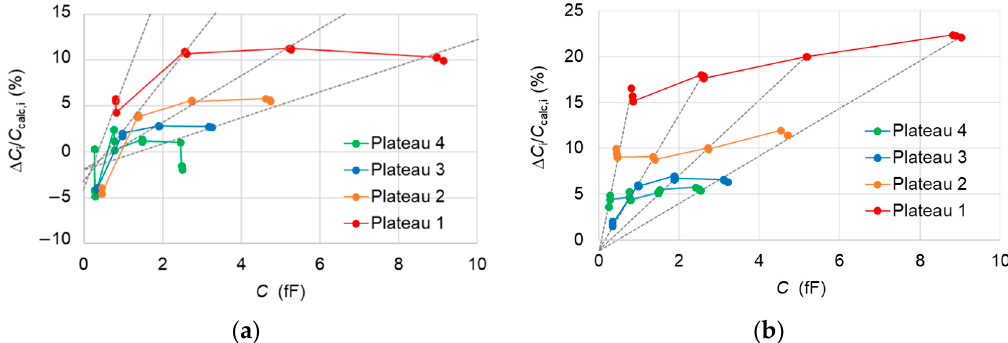
Figure 8. ( a ) Differences Δ C i / C calc,i = ( C i,A45 − C i,A61 )/ C calc,i in percentage between the measured values C i,A45 on the 12 capaci- tors of a given plateau of A61F08 pattern when the SMM is calibrated using triplets from A45E08 pattern and the measured values C i,A61 when the SMM is calibrated with the equivalent triplets from A61F08. The triplets used are (1,11,12), (17,18,19), (28,30,33) and (41,42,44) for measurements on the plateau 1 (red), 2 (orange), 3 (blue) and 4 (green). ( b ) Differences Δ C i / C calc,i = ( C i,A64 − C i,A61 )/ C calc,i with the patterns A61E07 and A64F07 which replace A61F08 and A45E08, respectively. The triplets used are (5,6,8), (16,18,21), (29,30,32) and (40,42,47) for measurements on the plateau 1 (red), 2 (orange), 3 (blue) and 4 (green). Dashed lines are linear fits for the capacitors of same diameter. The error bars varying between 2% and 3% have been omitted for clarity.